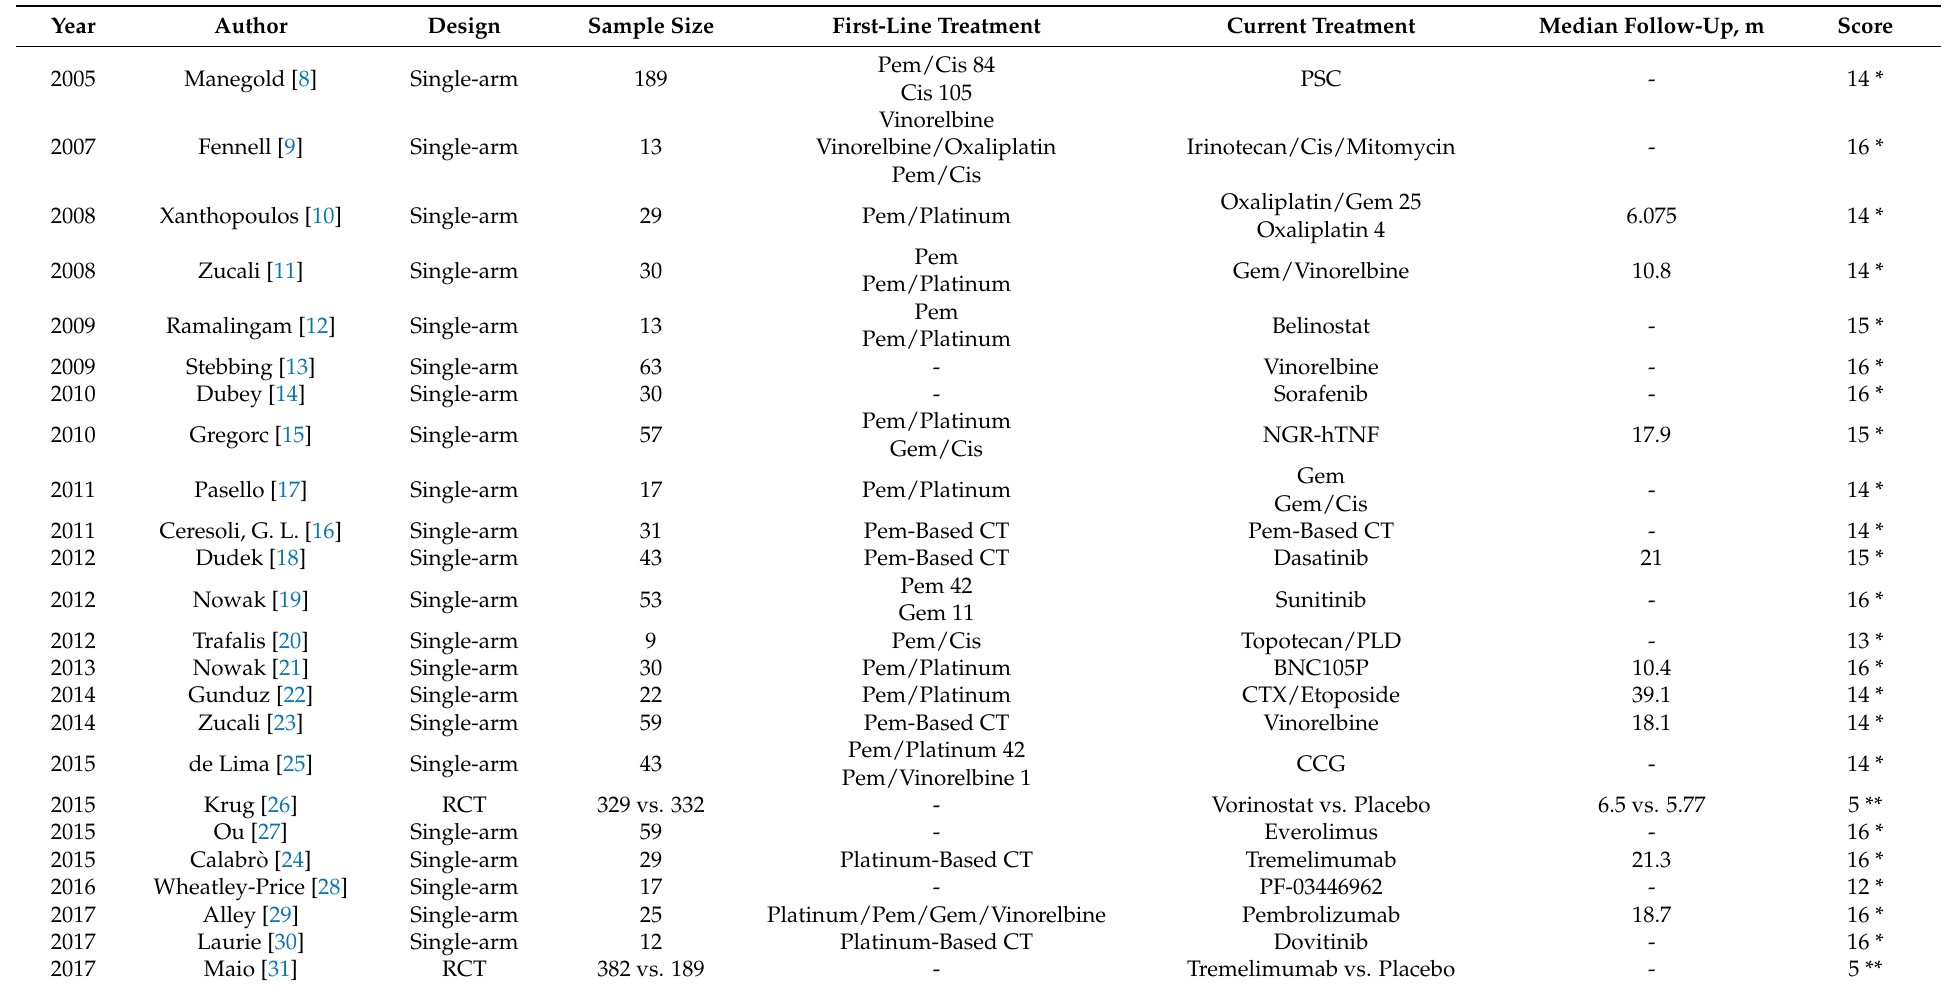
Table 1. Characteristics of included